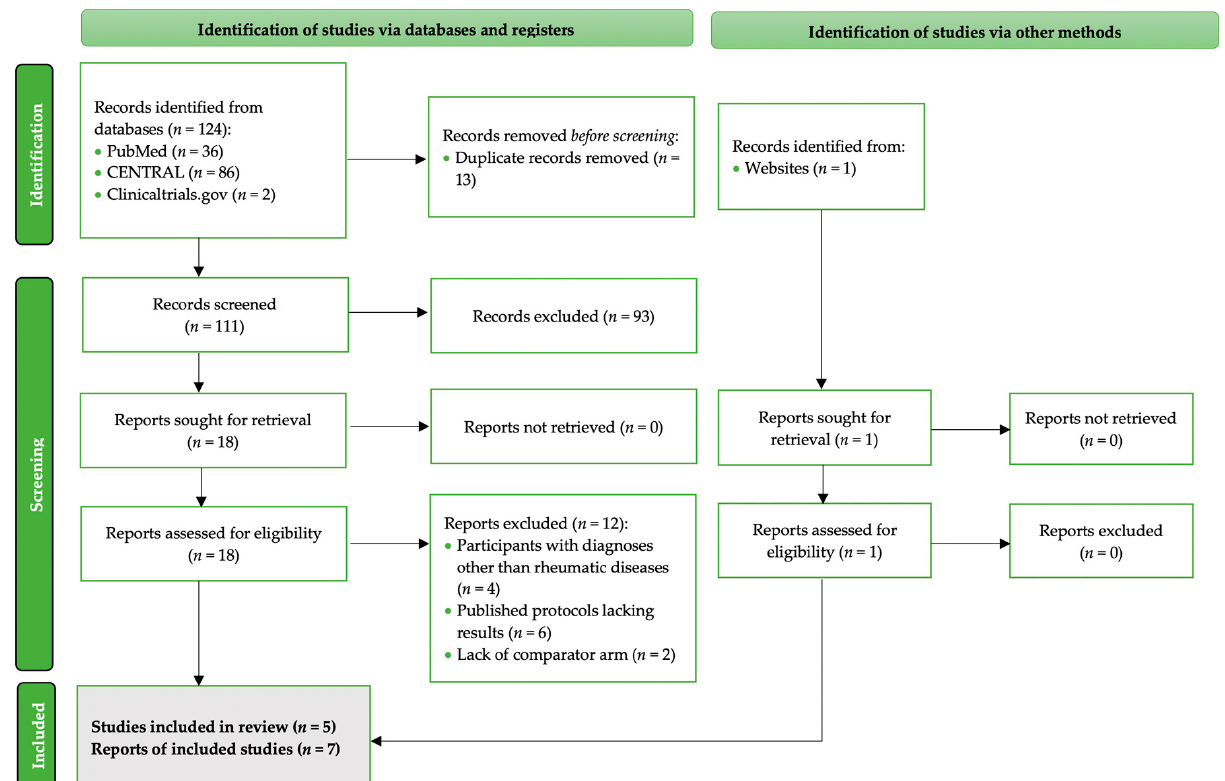
Figure 2. PRISMA [19] flow diagram of the studies’ selection process.